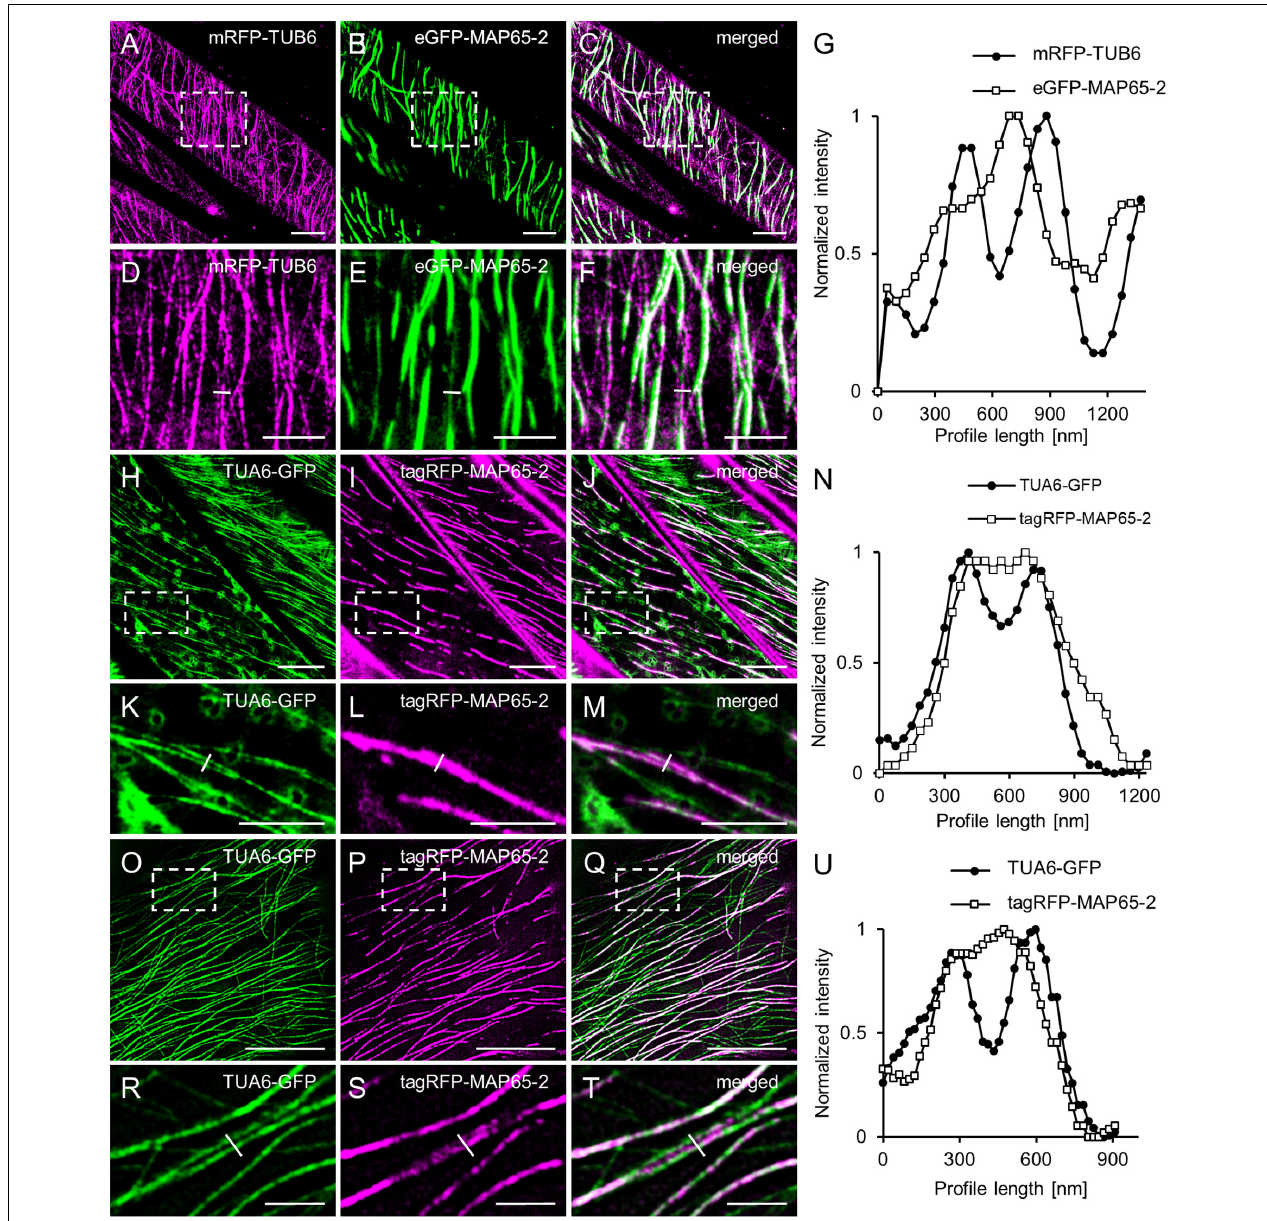
FIGURE 6 | Colocalization of MAP65-2 with microtubules. (A–C) ACLSM overview of microtubule bundles in hypocotyl cells coexpressing mRFP-TUB6 (A) and eGFP-MAP65-2 (B) ; merged picture is shown in (C) . Boxed area in (A–C) is shown in (D–F) ; (D) mRFP-TUB6, (E) eGFP-MAP65-2, (F) overlay; yellow line in (D–F) delineates fluorescence intensity profile, shown in (G) . Profile intensity measurement was normalized, plotted against distance and the resulting graph is in (G) . (H–J) ACLSM co-visualization of microtubule bundles in line coexpressing TUA6-GFP (H) and tagRFP-MAP65-2 (I) ; overlay is displayed in (J) . Boxed area in (H–J) is shown in (K–M) ; (K) TUA6-GFP, (L) tagRFP-MAP65-2 and in (M) is overlay; yellow line in (K–M) delineates fluorescence intensity profile, shown in (N) . After normalization, profile intensity measurement was plotted against distance and the graph is in (N) . (O–Q) Images of line expressing TUA6-GFP (O) and tagRFP-MAP65-2 (P) and their colocalization (Q) . Boxed area in (O–Q) is shown in (R–T) ; (R) TUA6-GFP, (S) tagRFP-MAP65-2 and in (T) is overlay; yellow line represents a perpendicularly drawn fluorescence intensity profile shown in (U) . After normalization, profile intensity measurement was plotted against distance